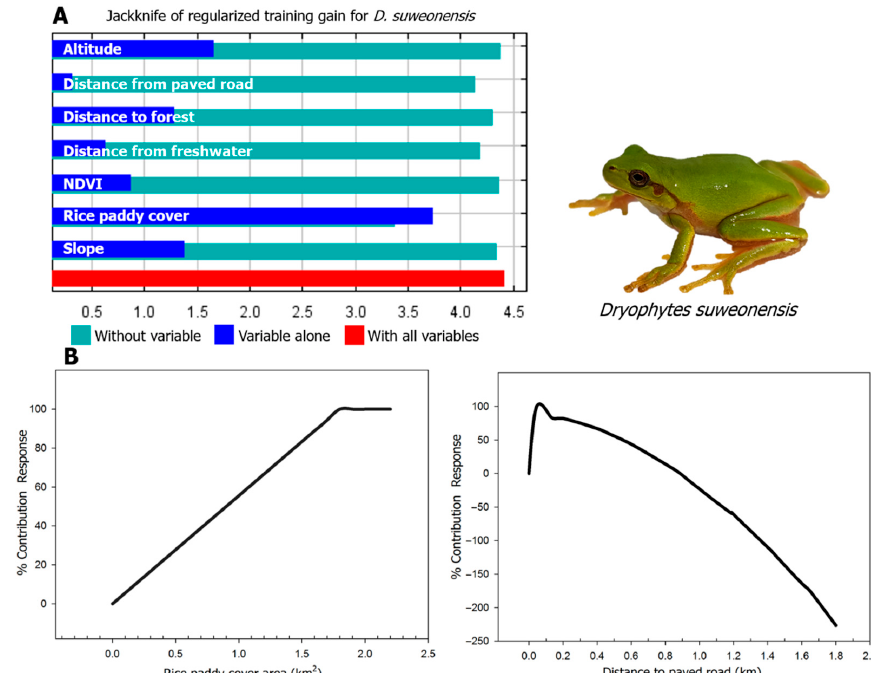
Figure 3. Jackknife test result and response curves of Dryophytes suweonensis to the two most important environmental variables in Hojobeol, Siheung, Republic of Korea. ( A ) Jackknife test for seven environmental variables. The horizontal blue bar shows that rice paddy cover has the highest gain and therefore it is most useful environmental variable to the model. The green horizontal bars also show that the omission of the variable rice paddy cover results in the largest decreases in gain, indicating a stronger impact than the other variables. ( B ) Response of D. suweonensis to rice paddy cover and distance to paved road. According to the response curve of rice paddy cover, habitat suitability increases with the size of the area of connected rice paddy, until reaching a plateau phase at about 0.19 km 2 . The distance to paved road to 45 m increased steeply up the suitability of D. suweonensis and gradually decreased